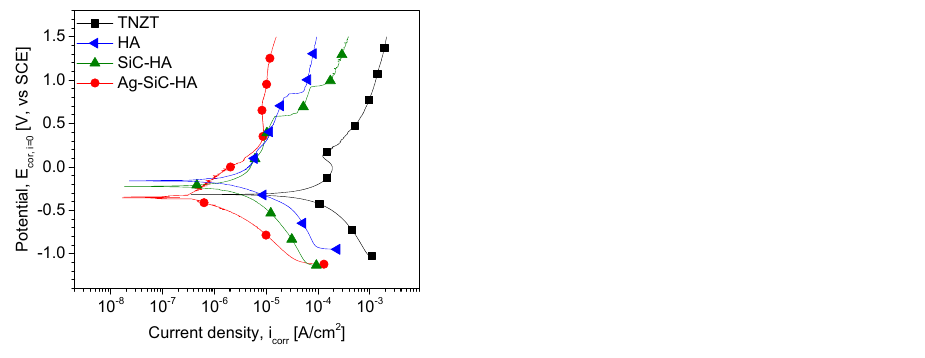
Figure 9. The potentiodynamic plots of the uncoated and coated samples in SBF corrosive solution at 37 ± 0.4 °C.